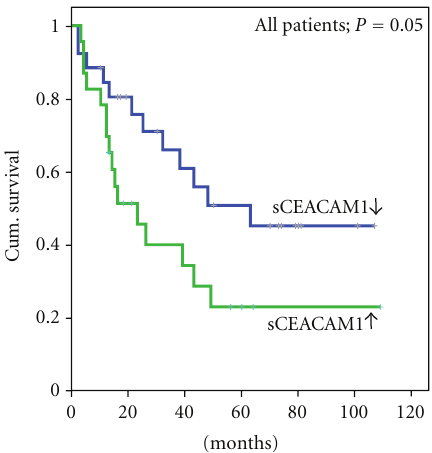
Figure 3: The change of sCEACAM1 following vaccination inversely correlates with survival. The change in sCEACAM1 following treatment (post minus pre-vaccination) was calculated and the patients ( N = 49) were divided according to the trend of sCEACAM1 change. Kaplan-Meier plots were used to describe the survival rates of each subgroup of patients. Groups sizes were as follows: N = 26 (decreased sCEACAM1) and N = 23 (increased